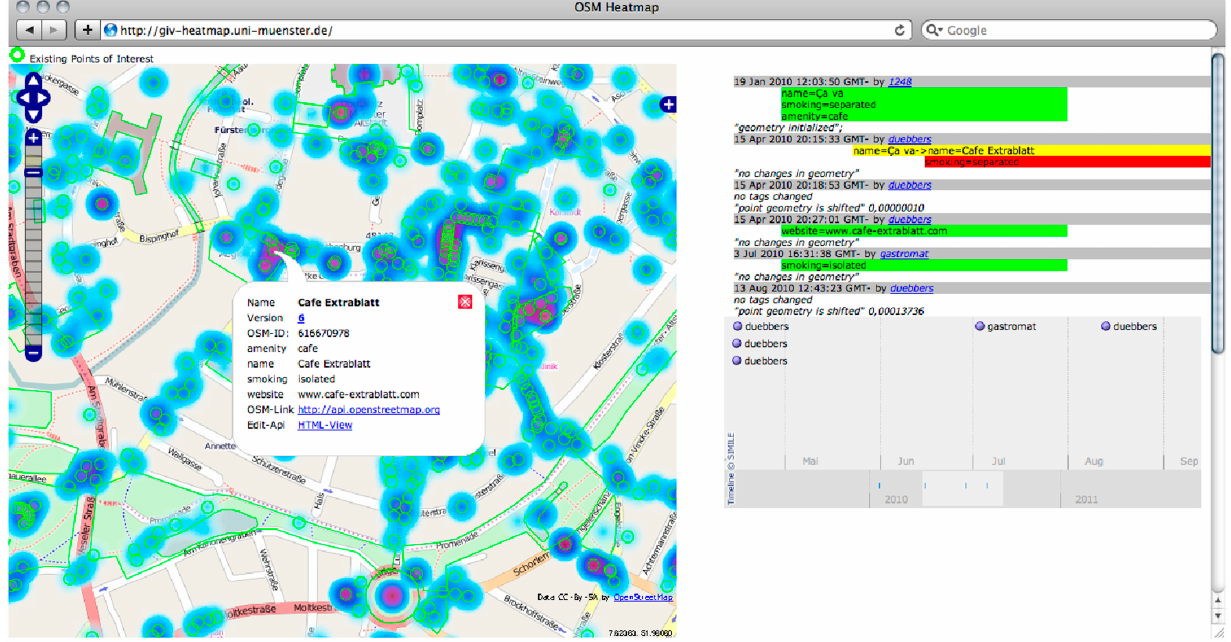
Figure 5. OSM editing heat map, with editing history and timeline of the selected feature on the